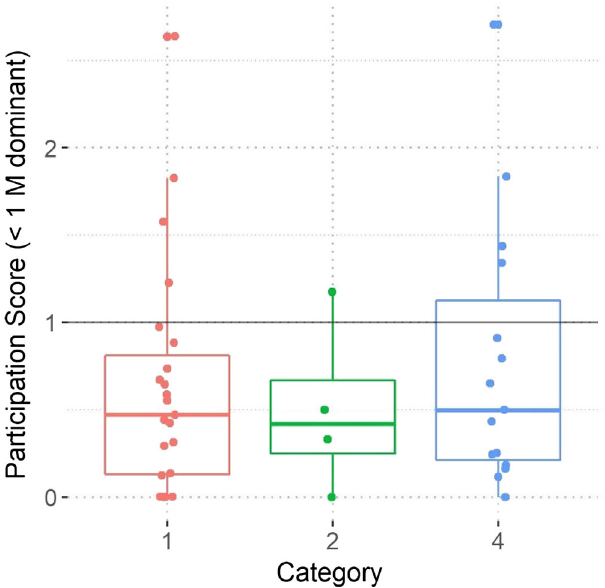
FIG. 2. Examining physics observations by category and participation score. Box-and-whisker plots of the participation scores in all categories within physics. Each point represents a class observation relative to the “ neutral ” participation score of one (horizontal line). The boxes show the median participation score in each category (center bar), the first and third quartiles (i.e., the 25 th and 75 th percentiles; “ hinges ” or outer lines of box), and 1.5 times the interquartile range ( “ whiskers ” or lines extending from boxes). The majority of observations have higher rates of participation of men (i.e., participation scores lower than 1), and the mean participation scores do not differ from each other. Category 1 is for lectures with clicker activities as its main active-learning component; Category 2 is for lectures with either demonstrations or other active learning as its main active-learning component; and Category 4 is a combination of clickers as well as demonstrations or other active-learning